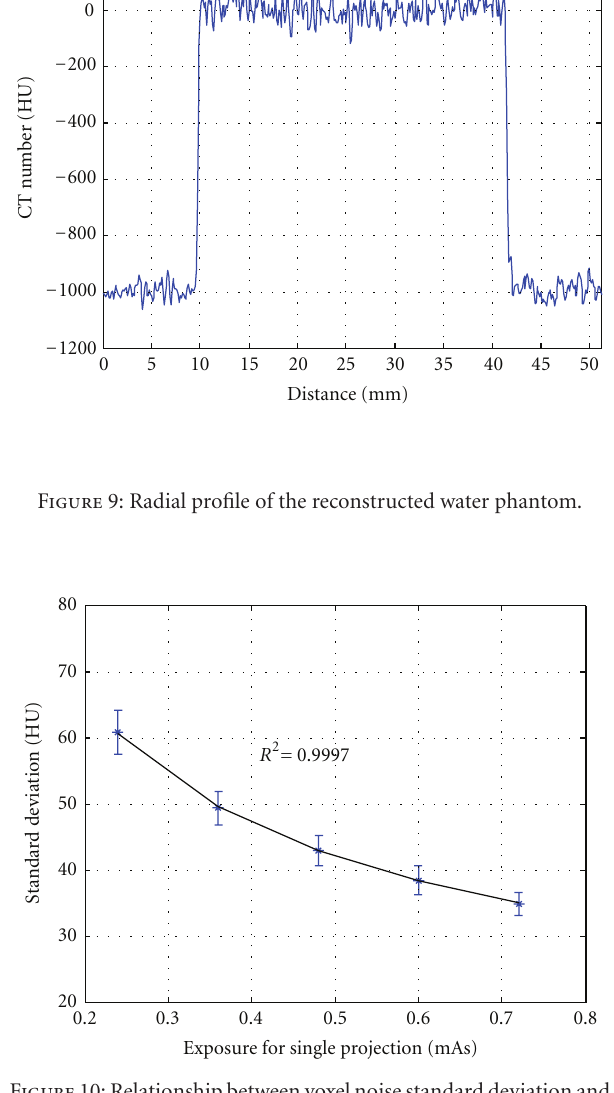
Figure 10: Relationship between voxel noise standard deviation and exposure